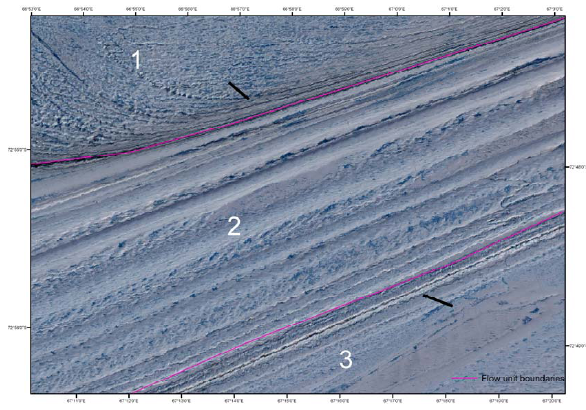
Fig. 7. Close up of part of the Lambert Glacier showing dif- Figure 7. Close up of part of the Lambert Glacier showing differences in ferences in spacing of longitudinal surface structures at flow-unit spacing of longitudinal surface structures at flow-unit boundaries and away boundaries and away from flow-unit boundaries. Arrows indicate from flow-unit boundaries. Arrows indicate closely spaced longitudinal surface closely spaced longitudinal surface structures at the boundaries of structures at the boundaries of flow units 1&2 and 2&3. These contrast with flow units 1&2 and 2&3. These contrast with the longitudinal sur- the longitudinal surface structures developed within flow unit 2, inherited from face structures developed within flow unit 2, inherited from further further up-glacier, which are more widely spaced. up-glacier, which are more widely